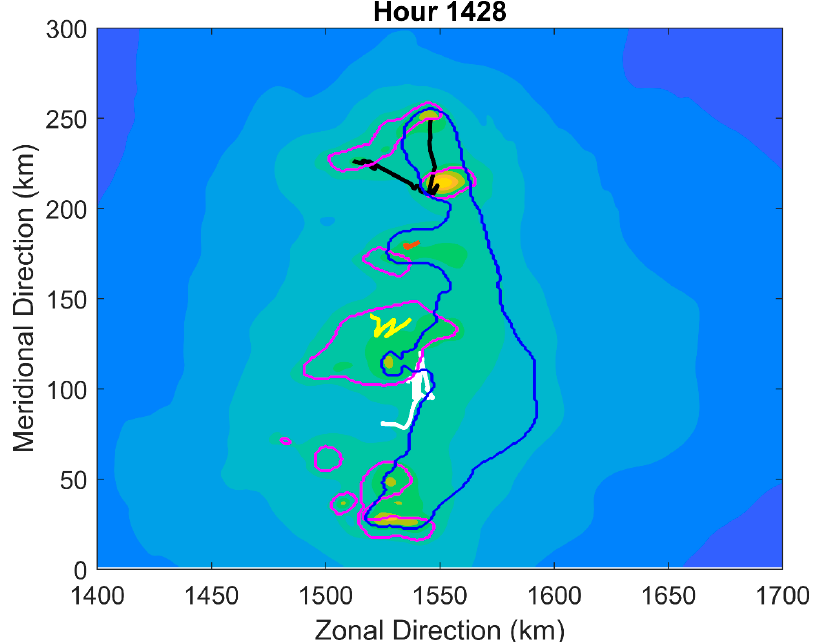
Figure 2. A snapshot of the horizontal distribution of <RH> in a small section of the simulation domain (colored contours; same color scheme as Igel et al. [24]). Regions of <RH> l over 0.63 (thick, blue contour) and <RH> u over 0.14 (thick, pink contour). Centroid locations of clouds tracked during hour 1428 (black, orange, yellow, and white).